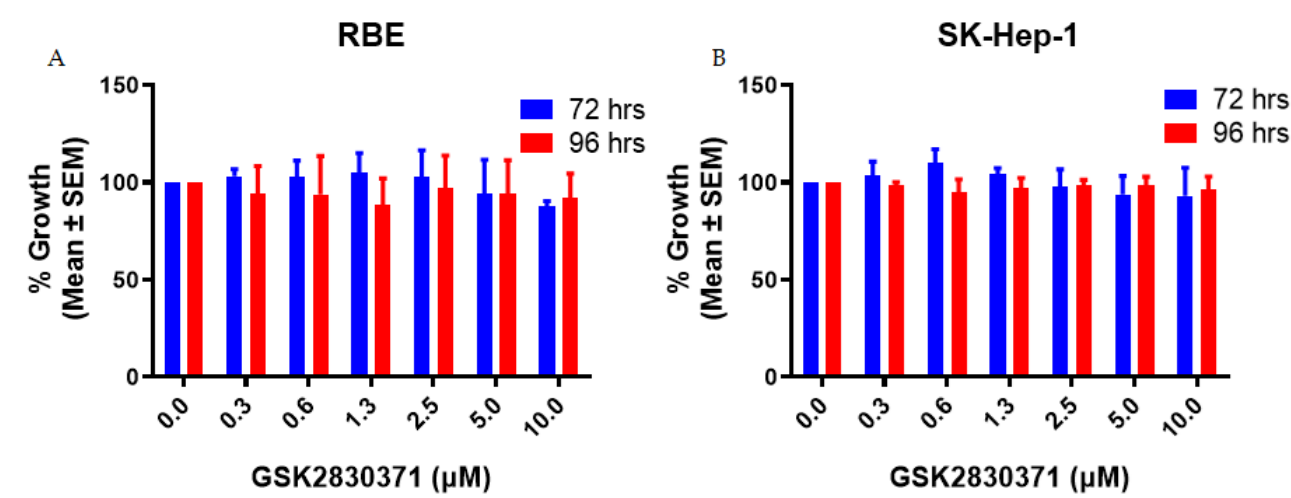
Figure 1. GSK2830371 alone exhibited minimal growth inhibitory activity. RBE ( A ) and SK-Hep-1 ( B ) cells were treated with 0–10 µ M GSK2830371 (WIP1 inhibitor) in 0.5% DMSO for 72 and 96 h. Minimal growth inhibitory activity was observed for GSK2830371 treatment alone. All data represent the mean ± SEM from three independent experiments performed in duplicate.